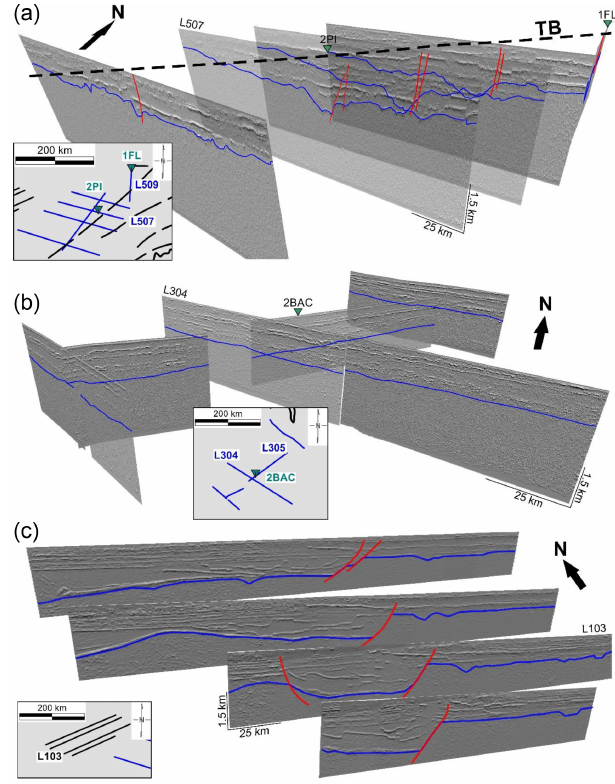
Figure 10. Interpreted seismic sections showing different tectonic styles in the eastern (a) , northern (b) and central (c) regions of the Parnaíba basin.